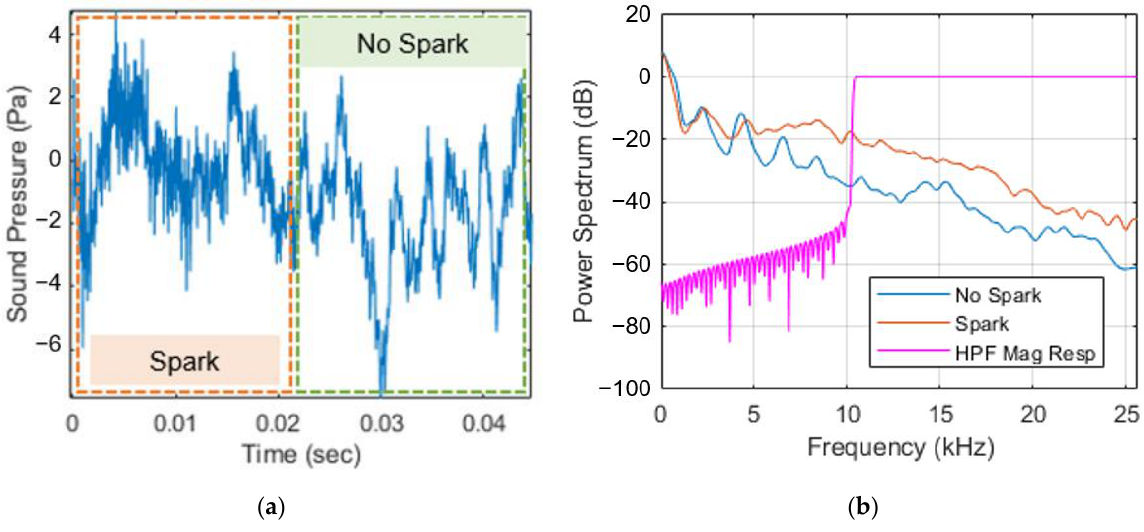
Figure 5. Comparison between spark and no spark signal: ( a ) time domain representation; ( b ) fre- quency domain analysis and magnitude response of the high-pass filter.